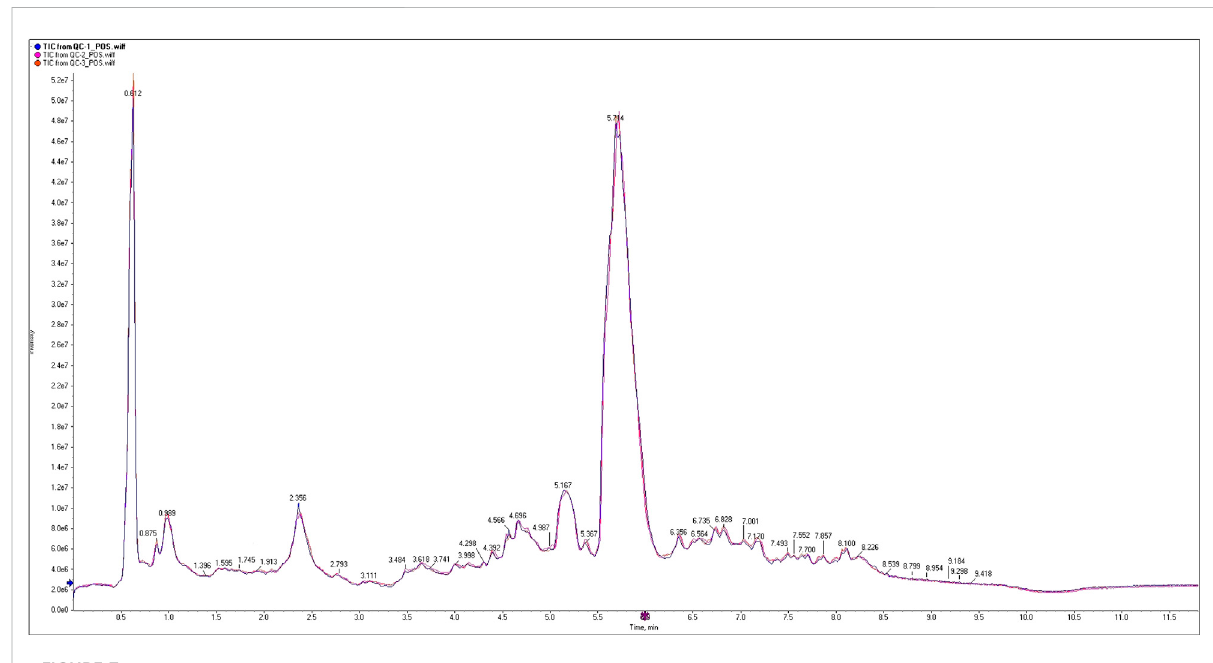
FIGURE 7 Total ion chromatogram for 3MI degradation products produced by strain AO-06.